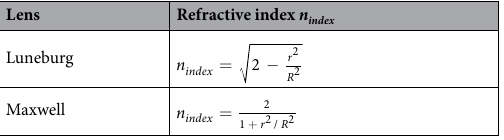
Table 1. Refractive index profile of the Luneburg lens and Maxwell lens.